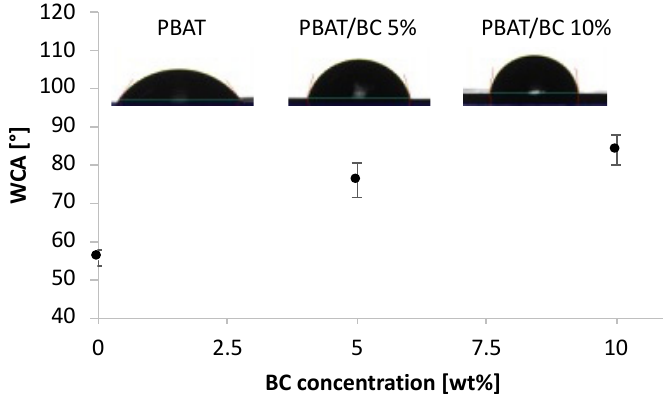
Figure 8. Water contact angles of PBAT, PBAT/BC 5%, and PBAT/BC 10%. PBAT films showed intrinsic hydrophilicity displaying a WCA value around 55 ◦ , whereas the addition of BC induced a noticeable increase in this value. More in detail, the WCA of PBAT/BC 5% and PBAT/BC 10% films was found to be equal to 76 ◦ and 84 ◦ ,